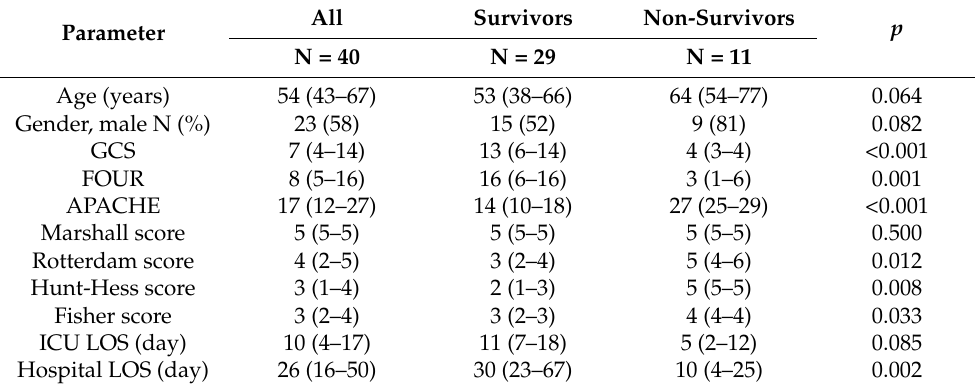
Table 1. Patient characteristics on admission to the ICU.